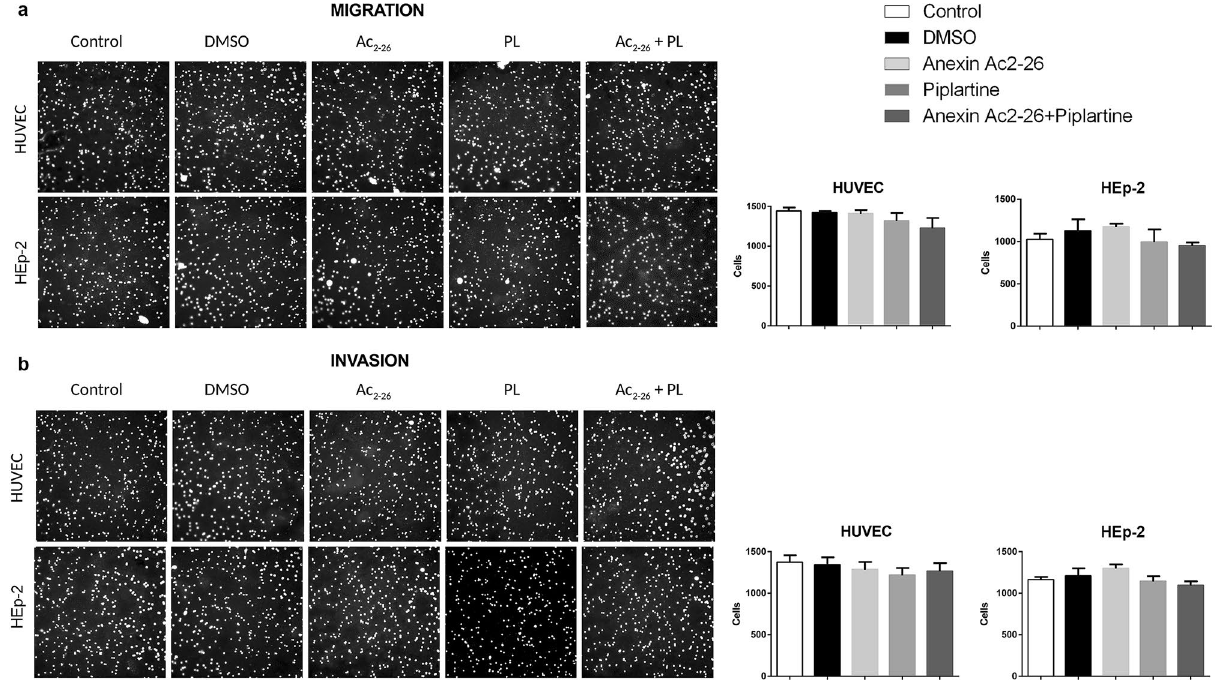
Figure 4. PL apparently has no effect on migration and invasion of HUVEC and HEp-2 cells. ( a ) Representative images of cell migration and ( b ) invasion assays performed on cells treated with PL alone or in combination with Ac 2-26 (cells stained by DAPI) (left panels). Quantitative analysis of the number of migrated and invasive cells relative to untreated controls (right panels). An equivalent volume of vehicle (final concentration in culture medium = 10 µg/mL) without PL or Ac 2-26 was added to the DMSO control group, and no DMSO/PL/Ac 2-26 was added to the negative control. Assays were carried out in triplicate (ANOVA * p < 0.05; ** p < 0.001).